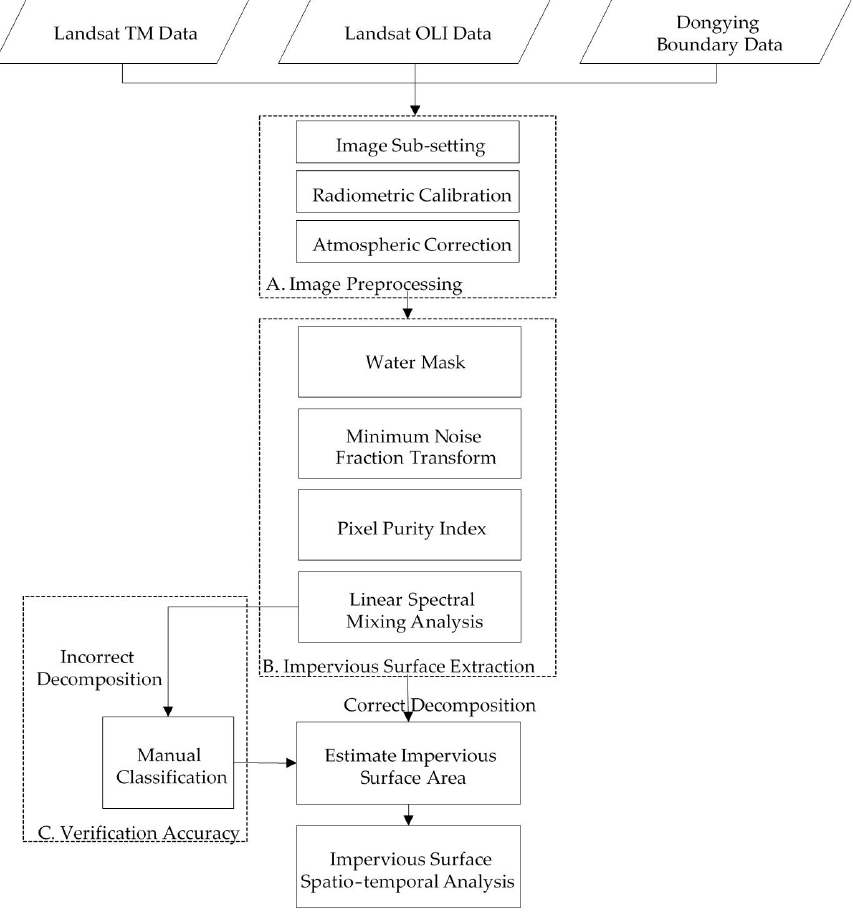
Figure 3. Flowchart for extraction and spatio-temporal analysis of ISA of Dongying from 1995 to 2018 based on Landsat data.